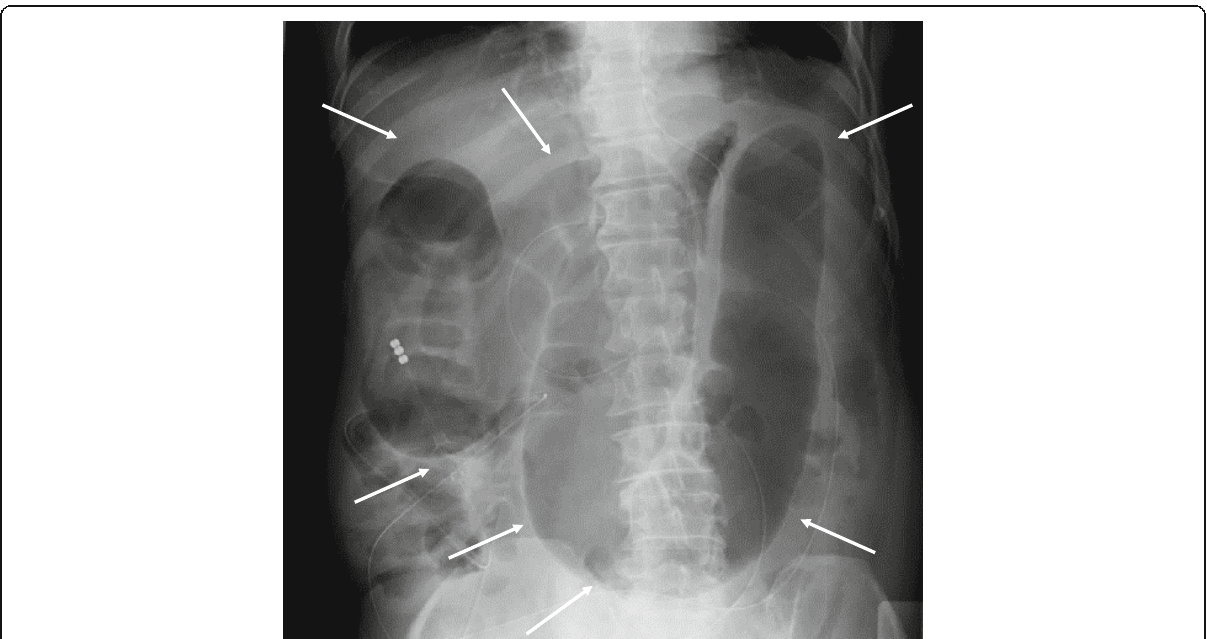
Fig. 2 Dilatation of the transverse colon was observed (white arrows)